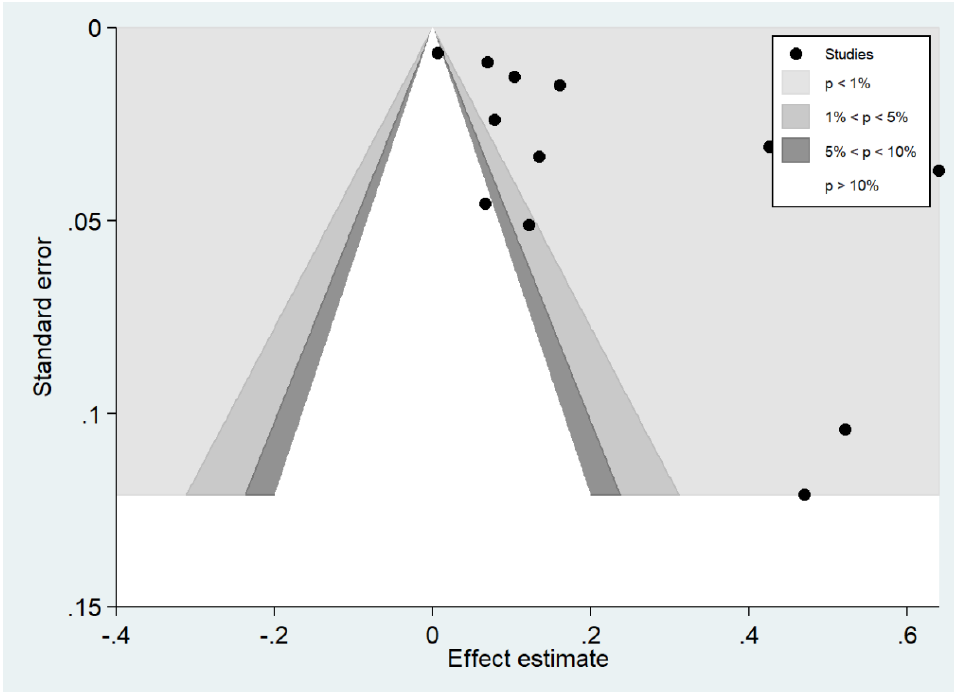
Figure 20. Contour - enhanced funnel plot .